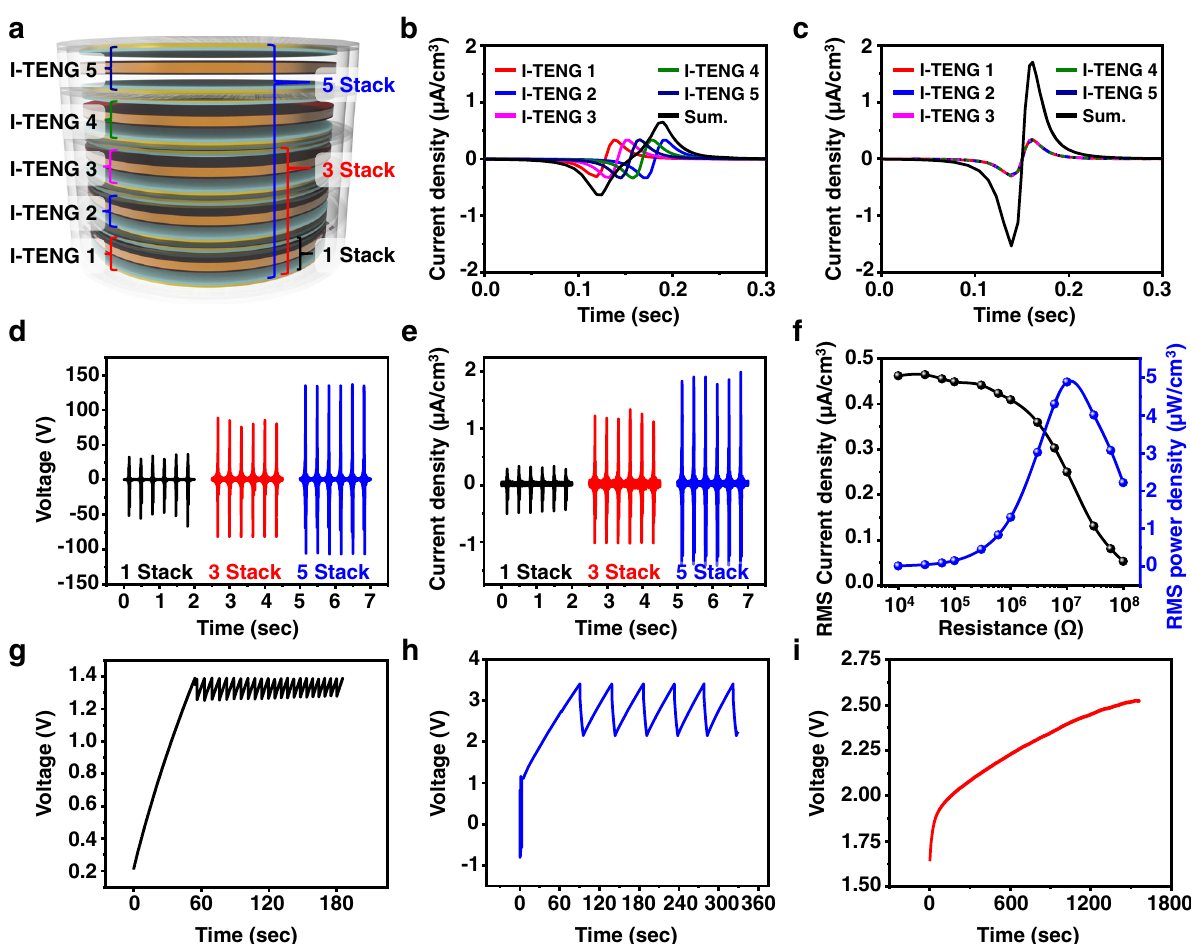
Fig. 2 The power performance of the I-TENG in the laboratory environment. a A schematic image of the stacked I-TENG. SPICE simulation results of ( b ) asynchronous TENGs and ( c ) synchronous TENGs. d Voltage output performance and ( e ) current output performance of one to fi ve-stacked I-TENGs. f Output RMS current and RMS power performance of the fi ve-stacked I-TENG as a function of the external load resistance. Charging behaviors of ( g ) fi rst and ( h ) second energy storages in PMIC and ( i ) battery by the stacked I-TENG.